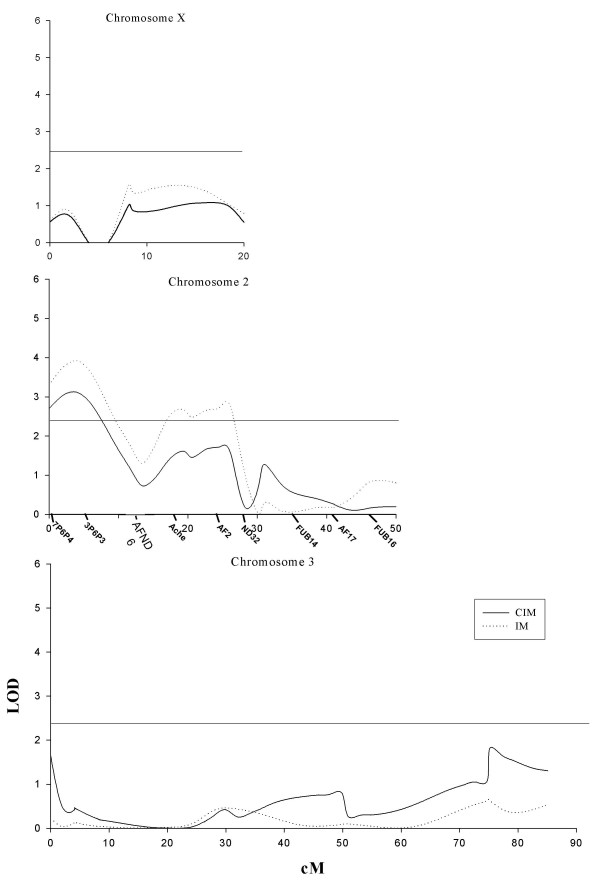
Plot of LOD scores associated with pyrethroid resistance on chromosomes X, 2 and 3 in family 4. Solid lines represent LOD estimated by composite-interval mapping and dashed lines represent LOD estimated by interval mapping. The straight line along the top of each graph represents the threshold value for LOD. Names of markers are listed on chromosome 2 to orient QTL position.